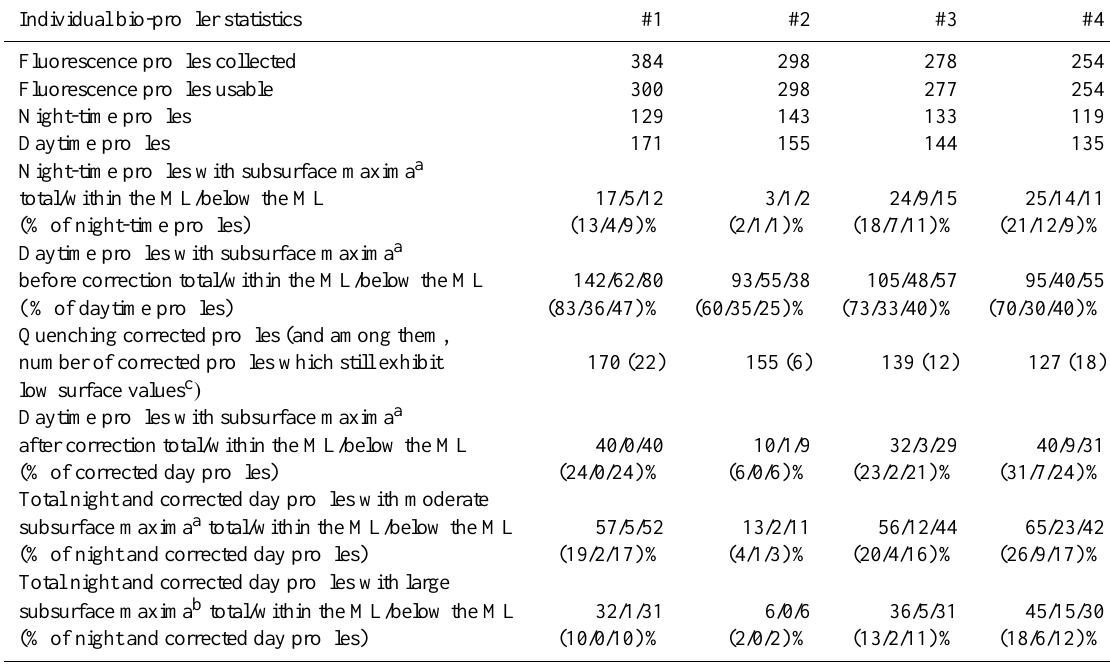
Table 3. Fluorescence quenching corrections and subsurface chlorophyll maxima statistics. Individual bio-profiler statistics #1 Fluorescence profiles collected Fluorescence profiles usable Night-time profiles Daytime